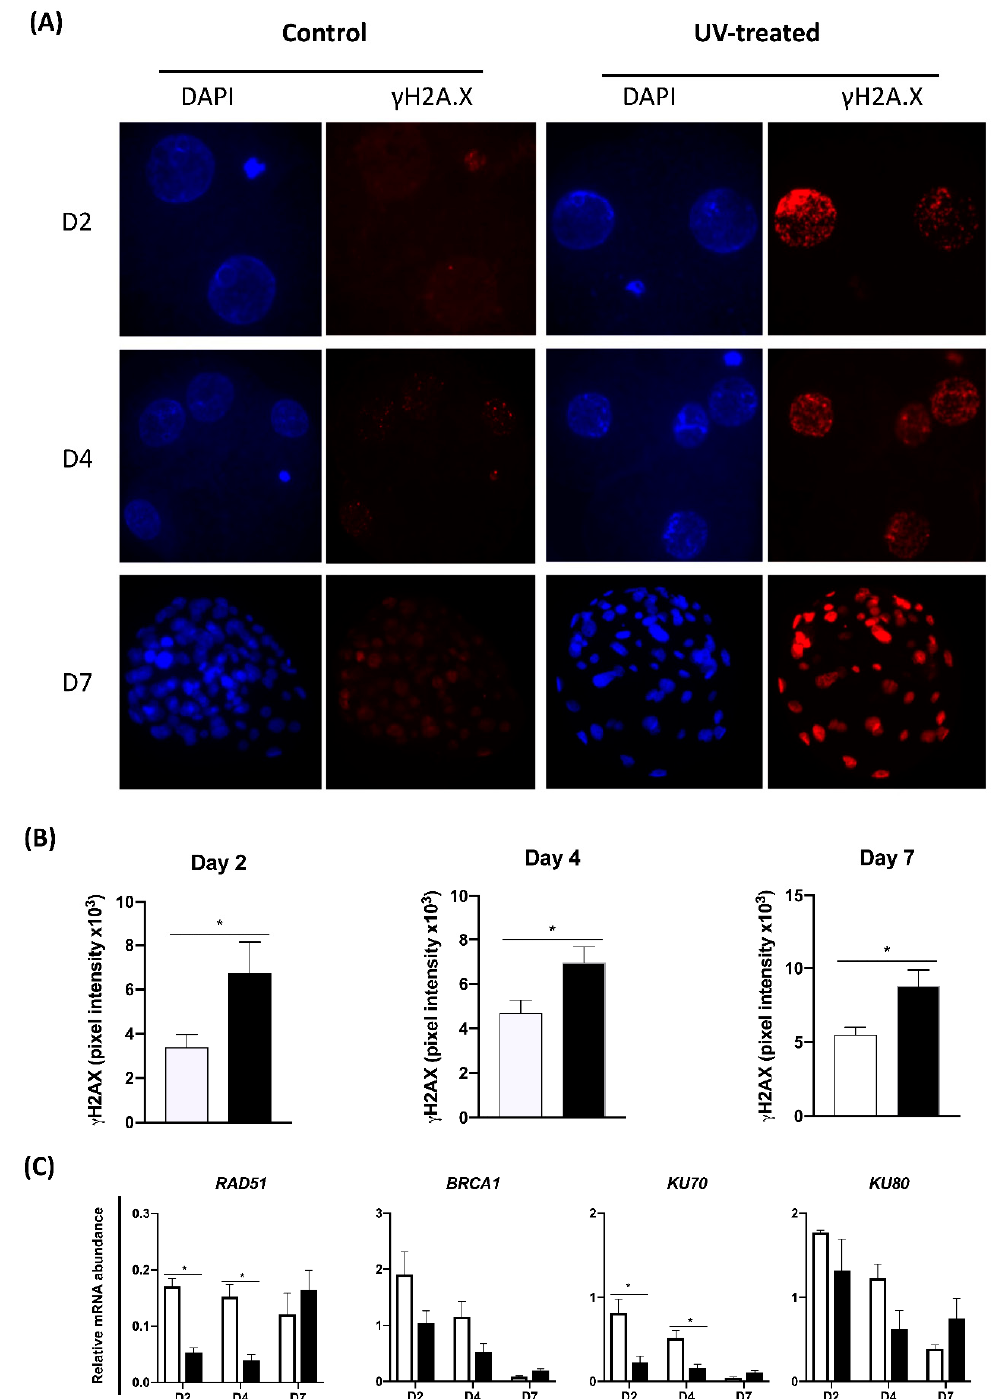
Figure 1. Effect of UV treatment for 10 s on DNA damage and expression of DNA repair regulators. ( A ) Representative images of control and UV-treated embryo at D2, D4 and D7 of development. Blue, cell nuclei stained with DAPI. Red, immunofluorescence signal of γ H2A.X indicating increased DNA damage in UV-treated embryos. ( B ) Quantification of immunofluorescent signal (Pixel intensity, arbitrary units) on the cell nuclear area (D2 and D4) or the entire embryo area (D7) in control and UV- treated embryos assessed 2 h after UV exposure. ( C ) Relative mRNA abundance of genes involved in the regulation of DNA damage repair by the HR (RAD51, BRCA1) and NHEJ (KU70, KU80) repair pathways. (cid:3) Control embryos; (cid:4) UV-treated embryos. Asterisks indicate statistical differences ( p < 0.05) between control and UV-treated